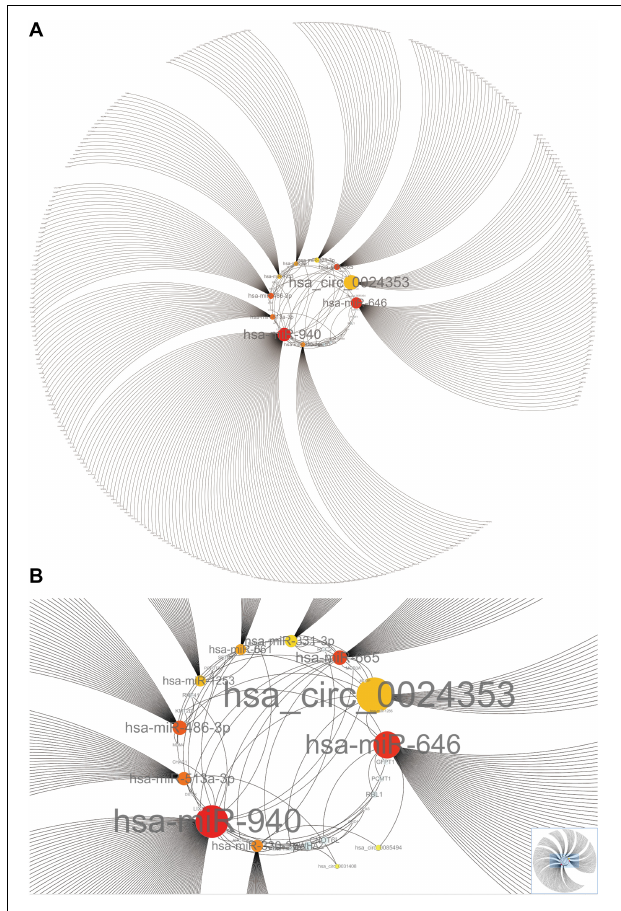
FIGURE 6 | The circRNA–miRNA-mRNA interaction network. (A) Overview of the entire network. (B) Specific relationship between circRNAs and interacting miRNAs in the network. Sizes of characters and circles represent the weight of circRNAs and miRNAs.